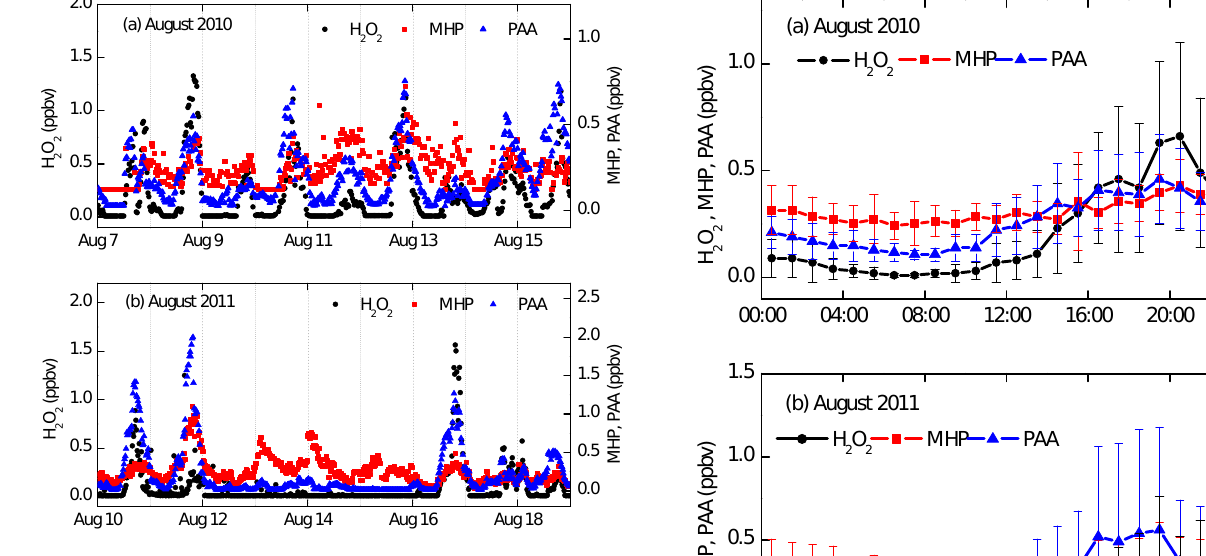
Fig. 1. Temporal profiles for peroxides in the summers of 2010 and 2011.